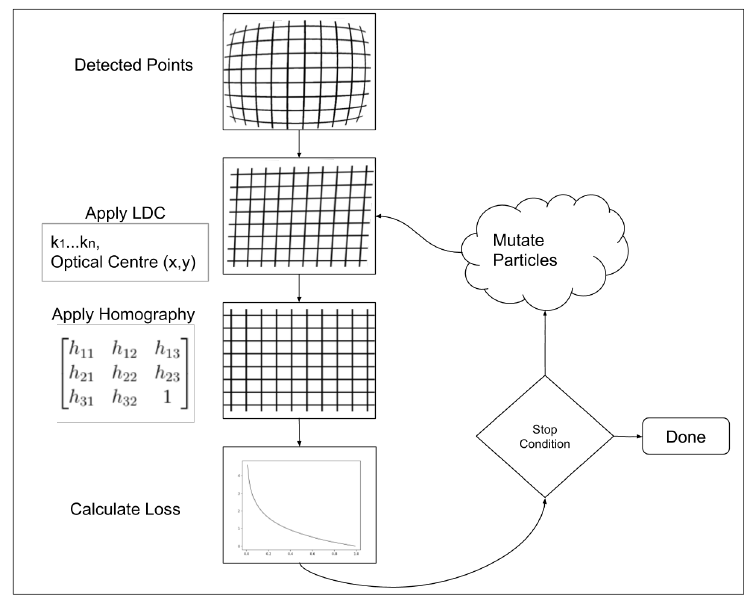
Figure 21. Distortion correction